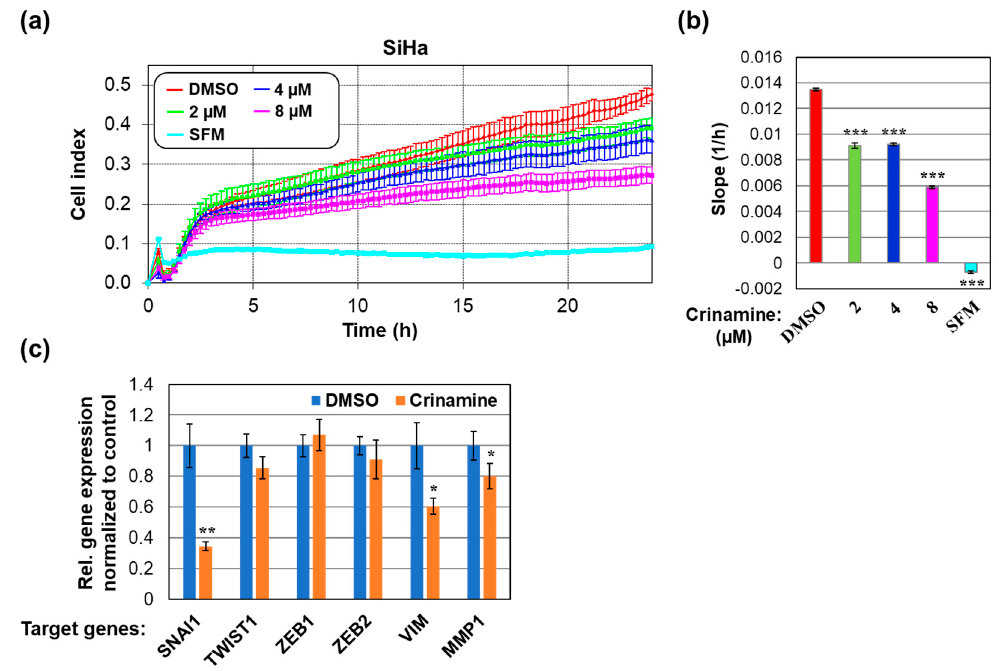
Figure 4. Inhibitory e ff ects of crinamine on cervical cancer cell migration. ( a , b ) Real-time migration of SiHa cells treated with the indicated concentrations of crinamine or DMSO. The rate of cell migration is presented as ( a ) cell index values and ( b ) the slope of the line between the 5 h and 20 h time points. Data are shown as mean ± SD from triplicate measurements. The results presented here are representative of data observed in two independent experiments. ( c ) The e ff ect of crinamine on mRNA expression of key genes involved in EMT and metastasis. SiHa cells were treated with DMSO or 12 µ M crinamine for 8 h followed by gene expression analysis by RT-qPCR. RNA levels were normalized internally to U6 snRNA and RPS13 and externally to the DMSO control. Bars represent the mean ± SD from triplicate measurements. * p < 0.05; ** p < 0.01; *** p <